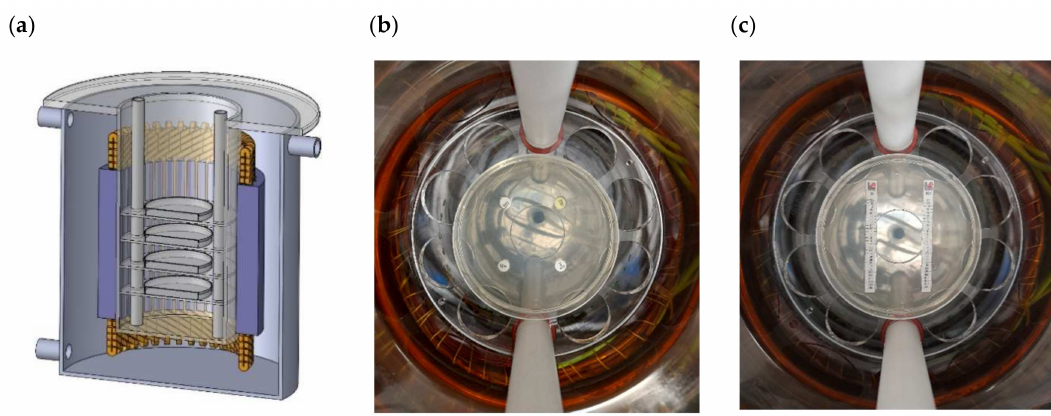
Figure 7. Location of Petri dishes ( a ) with antibiotic discs ( b ) and E-tests ( c ) in RMF